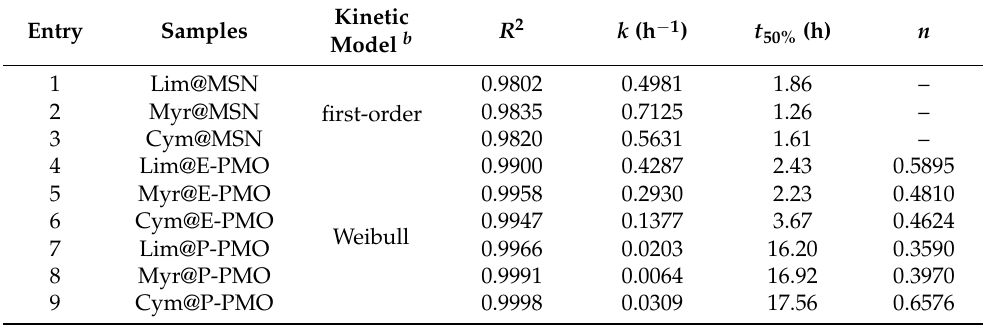
Figure 3. Fragrance release curves (symbol) of nanocomposites based on ( A ) MSN, ( B ) E-PMO NPs, and ( C ) P-PMO NPs, as measured by TGA of the samples at 30 ◦ C under a N 2 flow of 1.0 mL min − 1 . Dashed lines represent the corresponding fits with the first-order kinetics ( A ) and Weibull models ( B , C ), where y is the fraction of the released fragrance to the total amount of fragrance at time t , k is the release rate constant, and n is the release exponent. The initial fragrance load of the composites was controlled in the range 36–40 wt%, achieved by soaking excess NPs (1 g) in a limited amount (0.5 mL) of fragrance during the preparation. Table 2. Release kinetic parameters of fragrances from different carriers in isothermal TGA conditions and the correlation coefficients to the mathematical models a